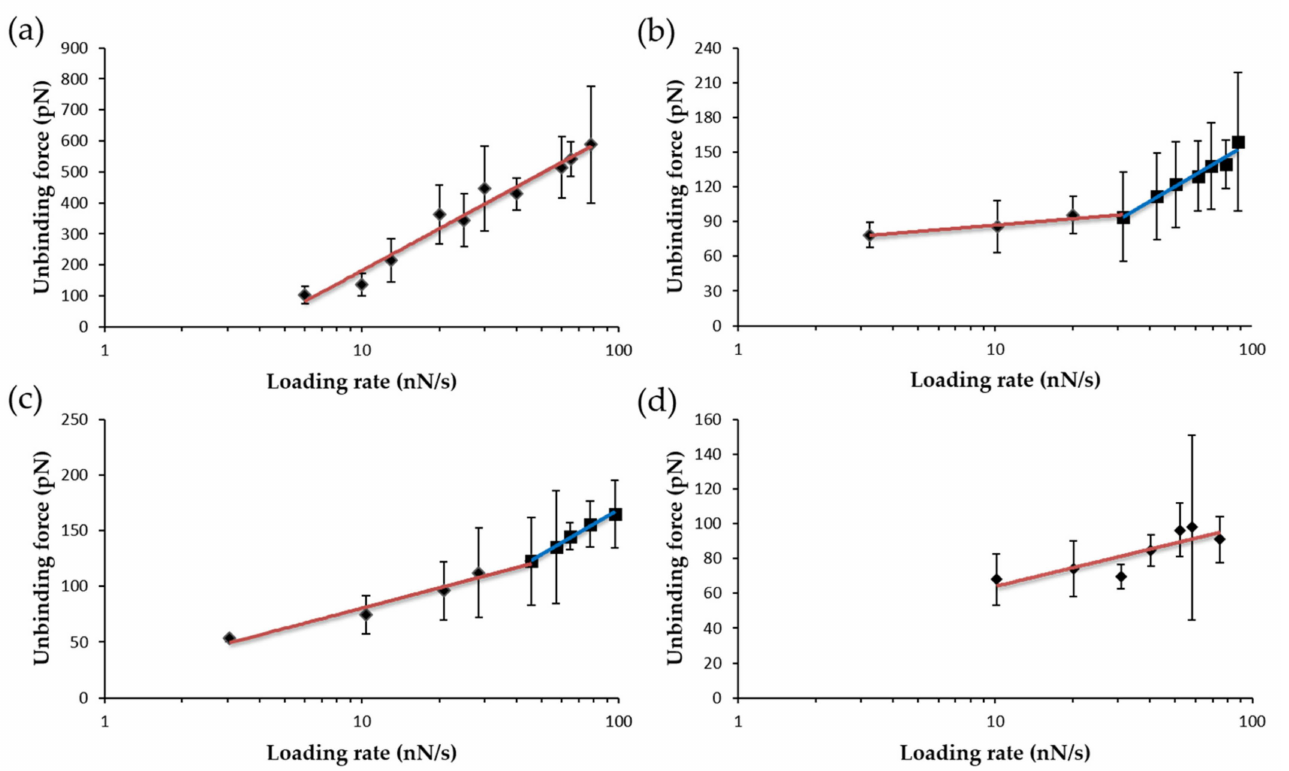
Figure 11. Loading-rate dependence of the most probable unbinding forces. Unbinding forces corresponding to the rupture of single complexes that result from the Gaussian fit to the histogram distributions of WT FNR ox :NADP + ( a ), Y303S FNR ox :NADP + ( b ), Y303F FNR ox :NADP + ( c ), and Y303W FNR ox :NADP + ( d ). Force statistical errors are given by standard deviation. The solid lines correspond to numerical fit of experimental data to the Evans–Ritchie expression [42]. Data from WT and Y303W FNR ox :NADP + complexes optimally fit to one straight line (red), whereas data from Y303S and Y303F FNR ox :NADP + complexes optimally fit to two straight lines (red and blue). Best-fitting nanomechanical parameters are shown in Table